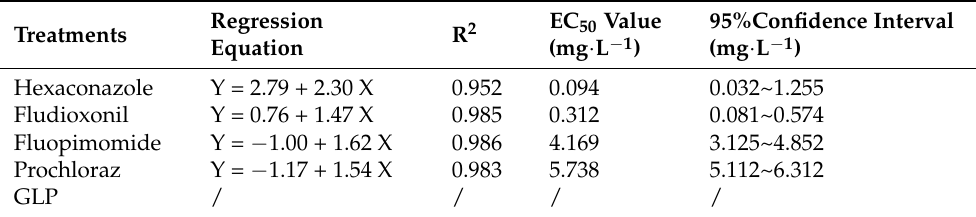
Table 4. In vivo assays test of GLP and fungicides on Rhizoctonia cerealis . Treatments